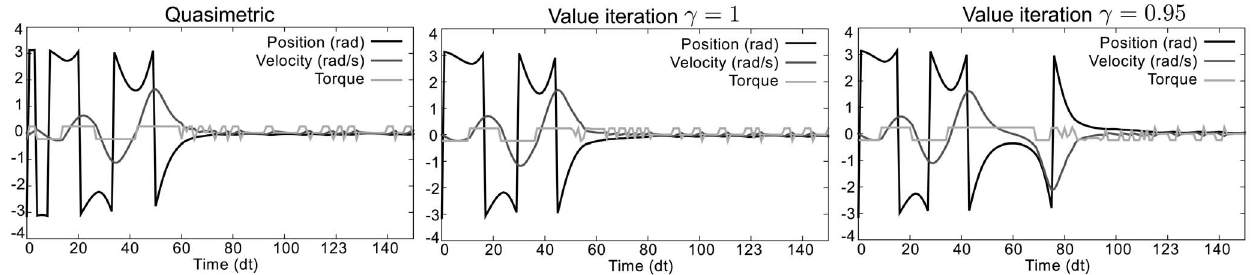
Figure 4. Behaviors obtained with quasimetric and dynamic programming methods with different discount factors. Starting from the initial stable state, both methods lead to the objective but with different trajectories.